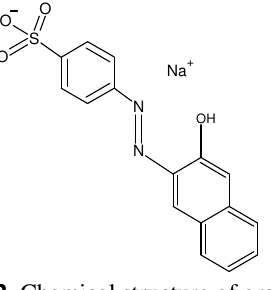
Figure 2. Chemical structure of orange II .